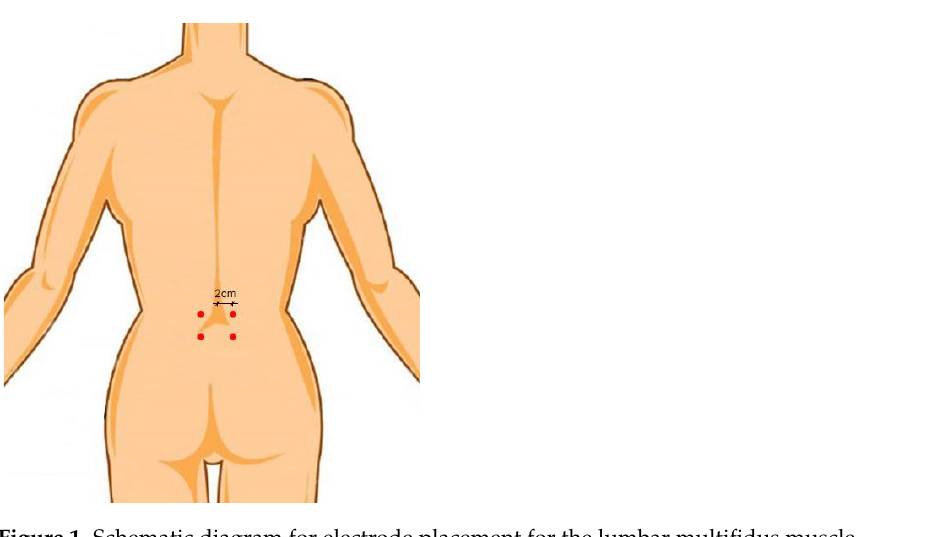
Figure 1. Schematic diagram for electrode placement for the lumbar multifidus muscle. Table 2. Procedures of the selected exercises.